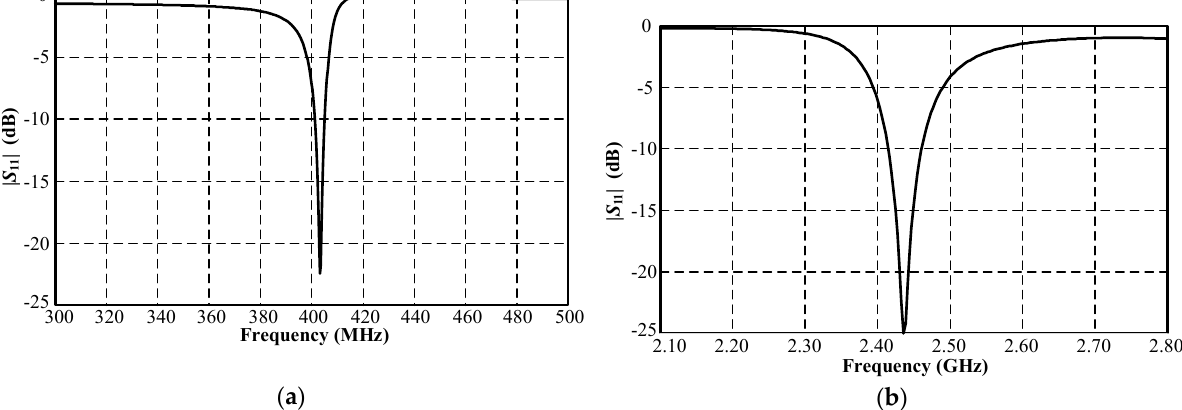
Figure 4. Simulated | S 11 | of MICS/ISM meander-line microstrip antenna encapsulated in a glass pod inside the muscular cubicle: ( a ) MICS and ( b ) ISM bands.